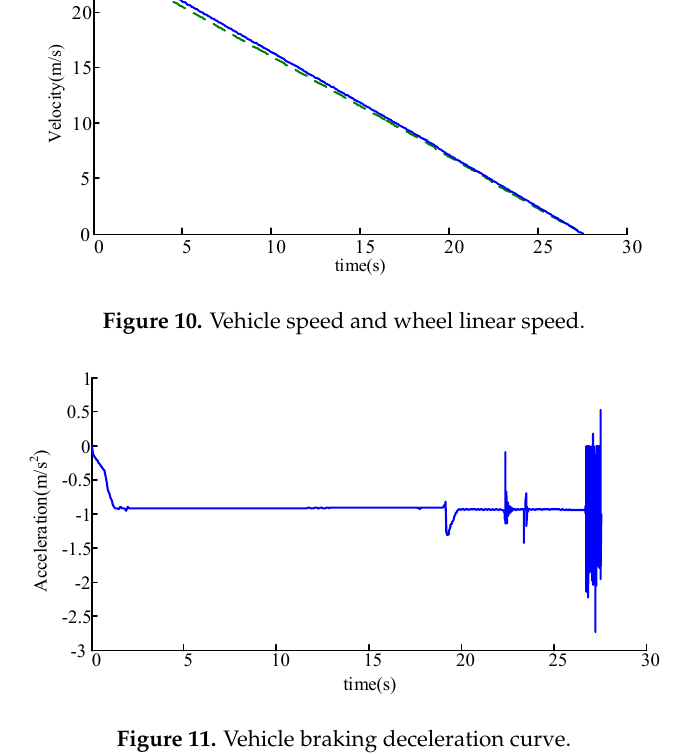
Figure 10. Vehicle speed and wheel linear speed.